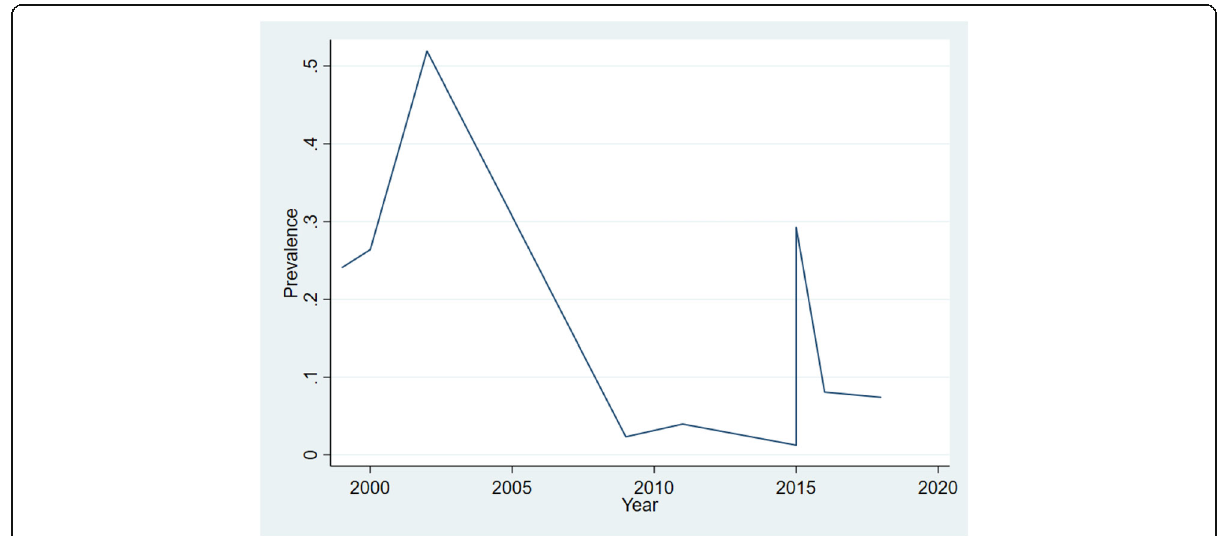
Fig. 4 Trends in the prevalence of HIV-associated esophageal candidiasis in sub-Saharan Africa